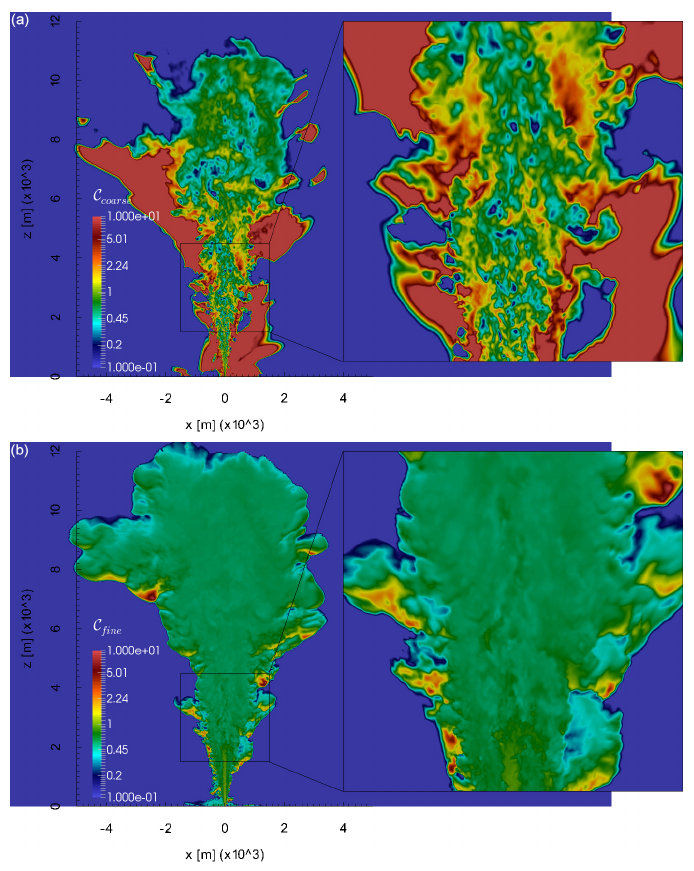
Figure 19. Distribution of C coarse (a) and C fine (b) , for the coarsest particles across a vertical section at t = 400s (see Eq.